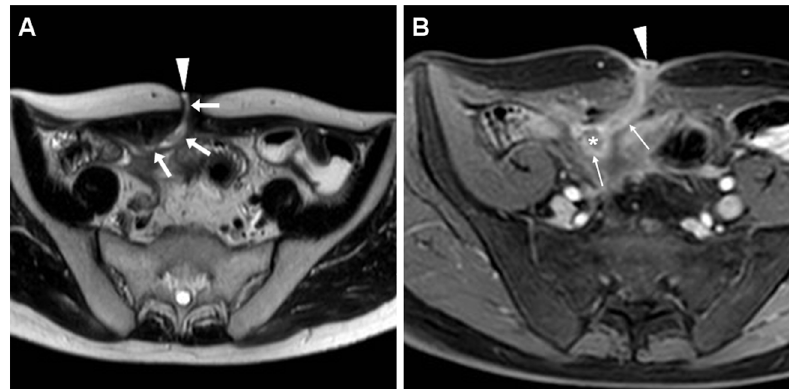
Fig. 9 Spontaneous ECF in a 37-year-old man with stricturing and fistulising CD, shown at MR-enterography as a fluid-like T2-hyperin- tense track (arrows in A ) coursing from an ileal loop through the abdom- inal wall, and finally reaching the EFO (arrowheads). Post-gadolinium